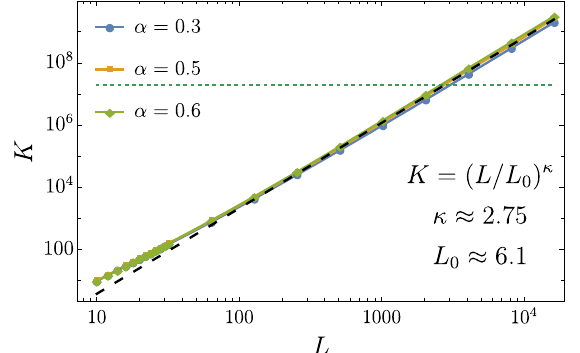
FIG. 11. Typical connectivity of the Heisenberg Hamiltonian in the tree basis obtained from the SDRG, as a function of the system size, for different values of disorder α ¼ 0 . 3 , 0.5, 0.6, 0.8, 1, 1.2 (see the legend). The dashed line represents the fit K ¼ ð L=L 0 Þ κ . The extracted value of κ ¼ 2 . 75 is in good agreement with the analytic result (18): κ ¼ ln 3 = ln ð 3 = 2 Þ ≈ 2 . 71 . The horizontal dotted line shows the maximal sampling rate ( 2 × 10 7 matrix elements) used in the search of resonances (see Secs. IV B and IV